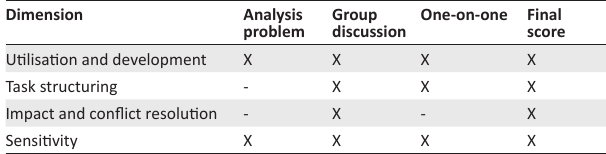
TABLE 1: Behavioural matrix: Leadership